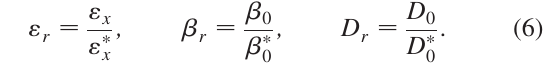
FIG. 2. Layout of another TME-like cell, with QD closer to the